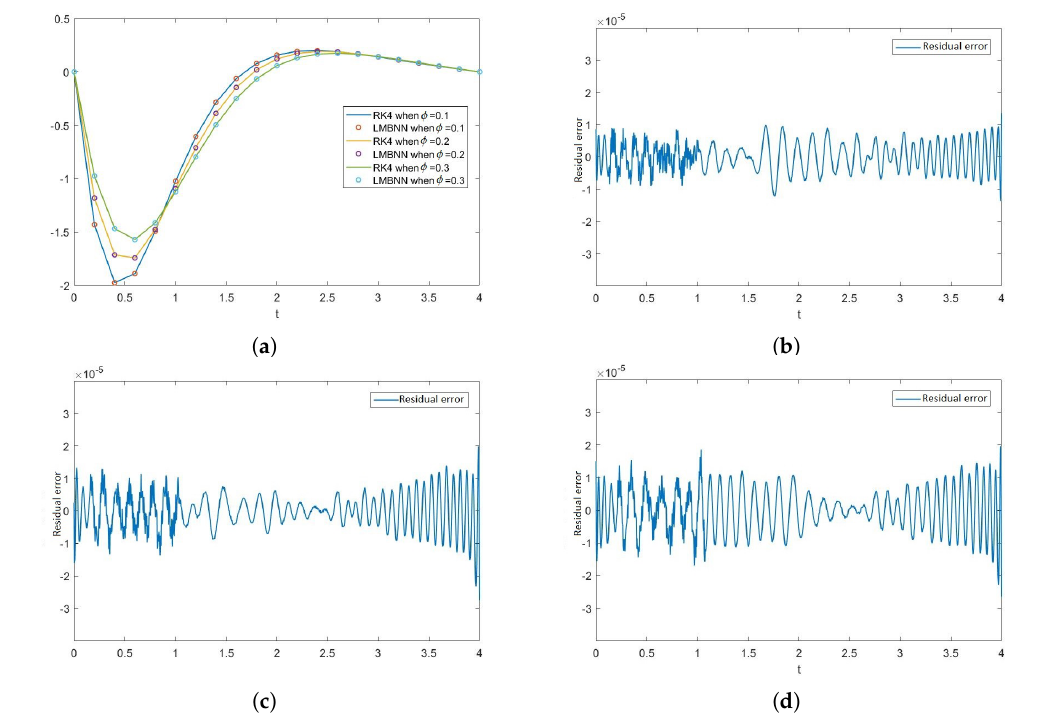
Figure 15. Graphs of Φ representing the outputs obtained from the RK4 and LMB-NN methods along with the graphs of the residual error between both the outputs. ( a ) Graphical representation of the outputs of Φ through the RK4 and LMBNN when φ varies. ( b ) Error graph of Φ when φ = 0.1. ( c ) Error graph of Φ when φ = 0.2. ( d ) Error graph of Φ when φ =